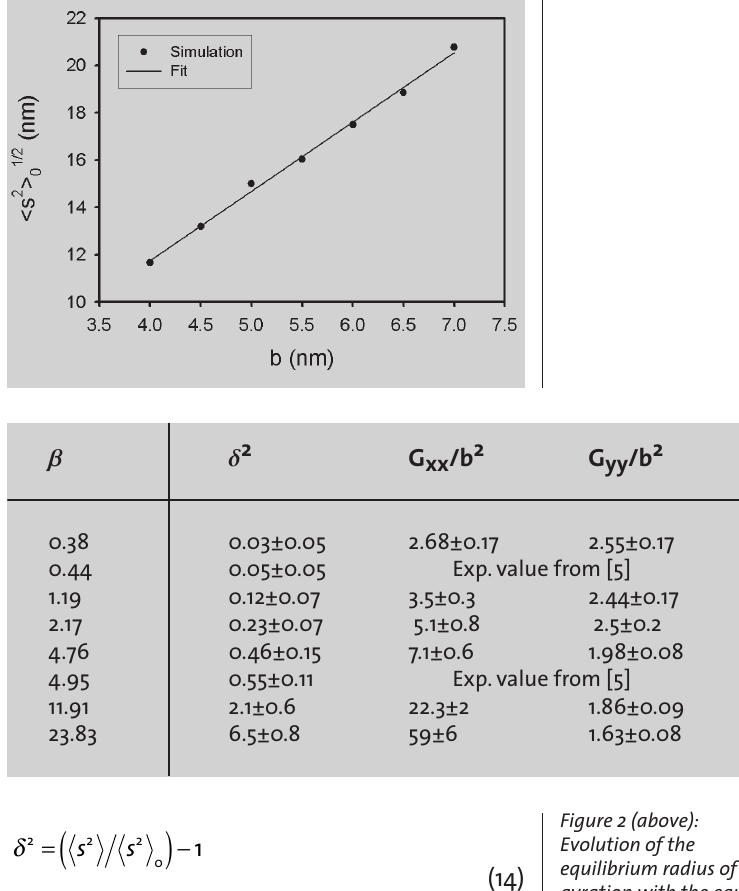
Figure 2 (above): Evolution of the equilibrium radius of gyration with the equilibri- um spring length, b, to find the value of the parameter b that best fit the experimental radius of gyration. Table 1 (below): Deformation with